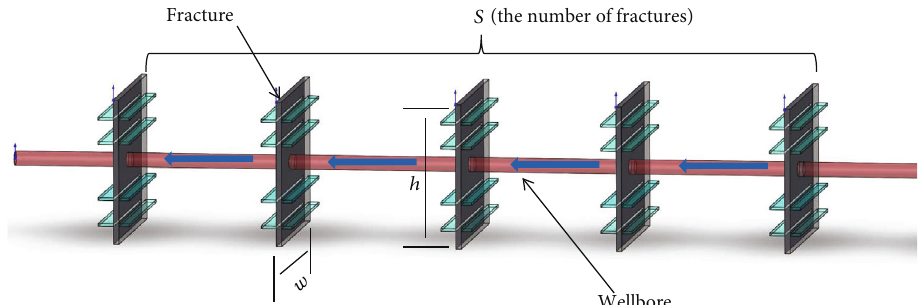
Figure 1: Hydraulic fracture fl owback model of shale gas